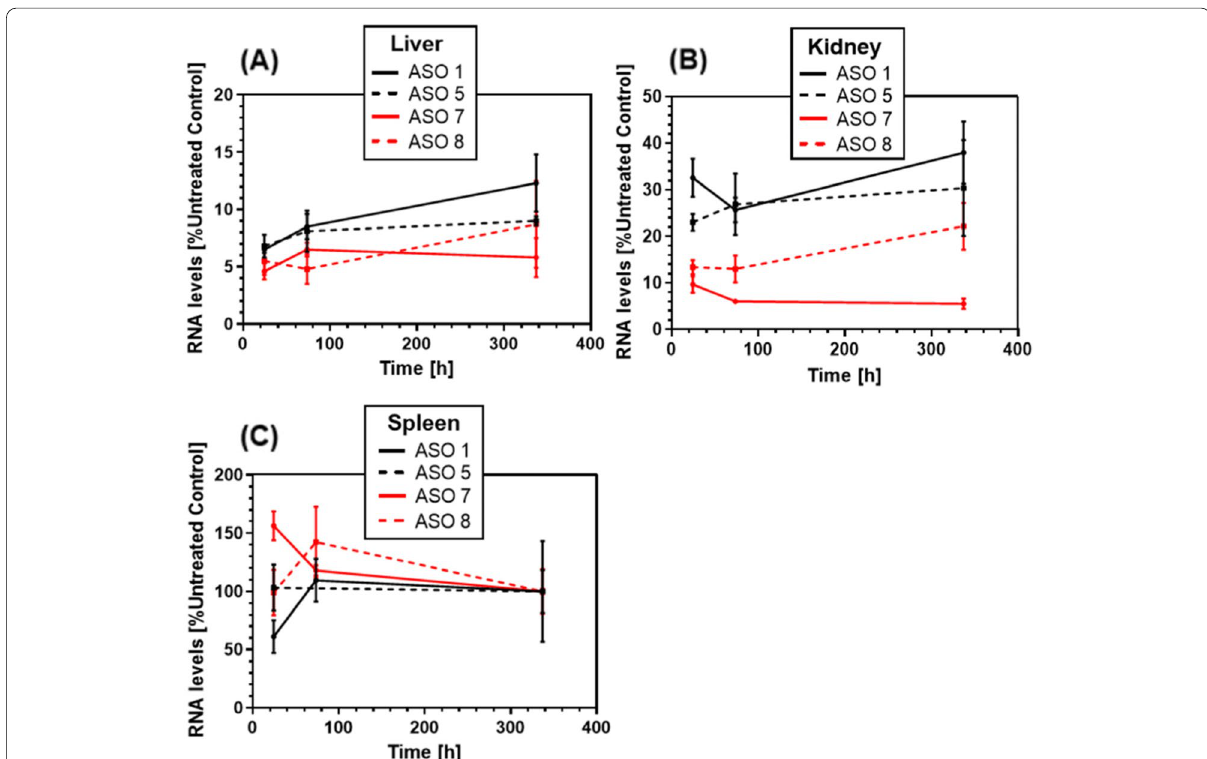
Fig. 7 Malat1 RNA levels after in vivo inhibition of ASOs 1 (naked), 5 (GalNAc), and [ 3 H]-labeled ASO 7 (naked), 8 (GalNAc) in liver ( A ), kidney ( B ), and spleen ( C ) (mean, n =